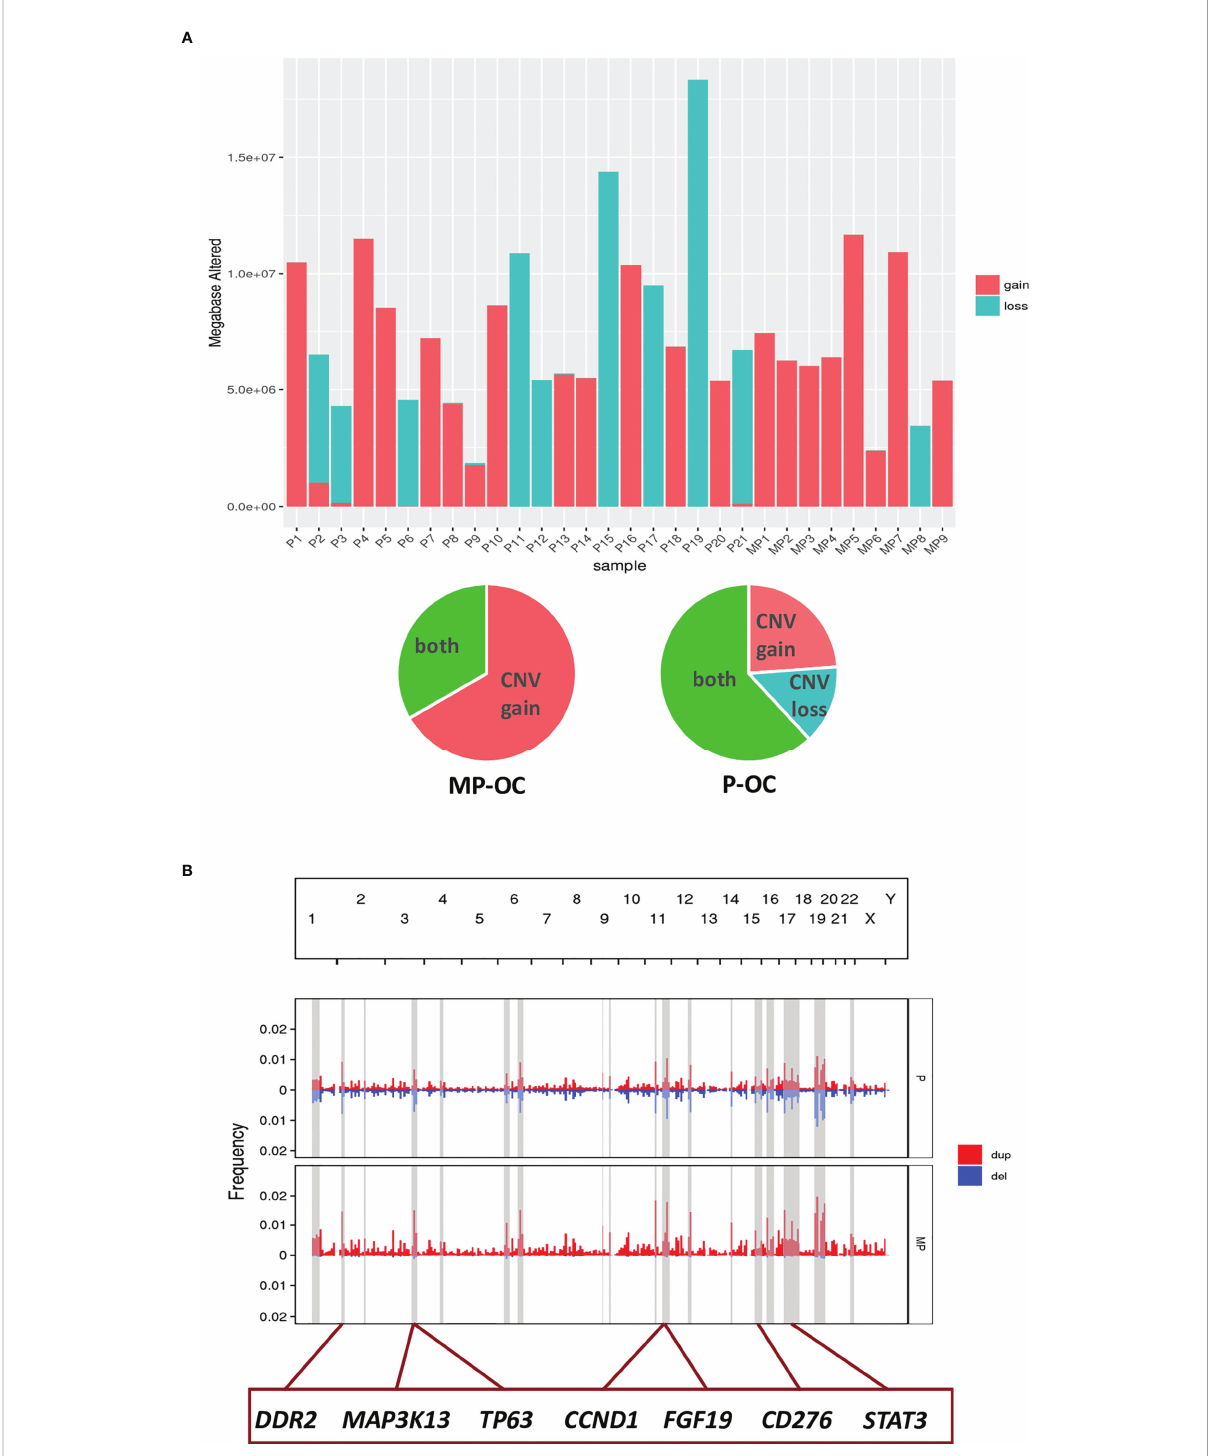
FIGURE 5 CNV in MP-OC and P-OC groups. Histogram showing CNV gains (red) and CNV loss (blue) in 9 MP-OC patients and 21 P-OC patients. Patients with CNV gains and CNV loss in the two groups were counted in the pie chart (A) . Composite of copy number pro fi les for the MP and P group, with gains in red and losses in blue. The regions that showed a difference in the frequency of copy number alterations between two groups were shaded in light gray rectangles; some genes in these regions are labeled (B)